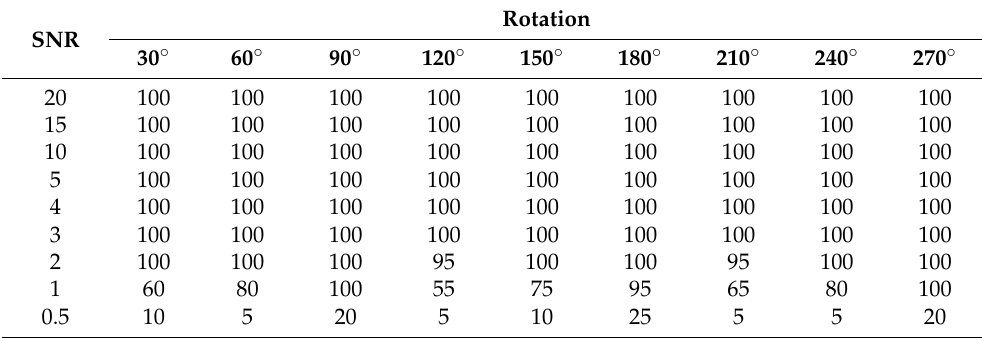
Table 12. The correct recognition rates for a combination of rotation angles and noise levels for the log-polar DWT-FFT2 method for the 2D aircraft